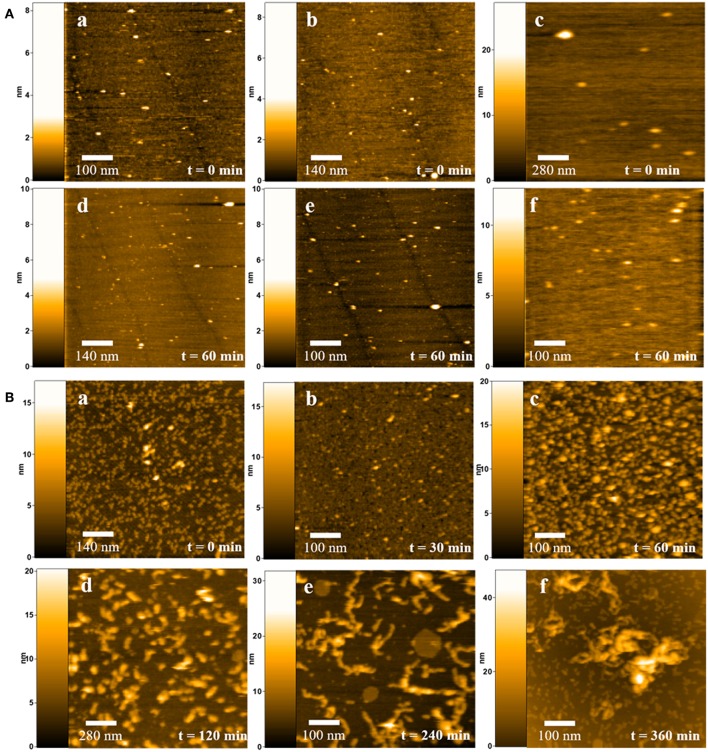
Dynamic AFM imaging of insulin fibrillation in the presence or absence of QDs at physiological conditions. (A) Insulin molecules at the zero point of measurement (a) and after 6 h of incubation (d); (b, e) insulin molecules in the presence of PEG-OH at the zero point of measurement (b) and after 6 h of incubation (e); CdSe/ZnS-S-PEG-OH QDs at the zero point of measurement (c) and after 6 h of incubation (f). (B) Dynamic AFM imaging of insulin fibrillation in the presence of CdSe/ZnS-S-PEG-OH QDs under physiological conditions for 0.5, 1, 2, 4, and 6 h incubations.